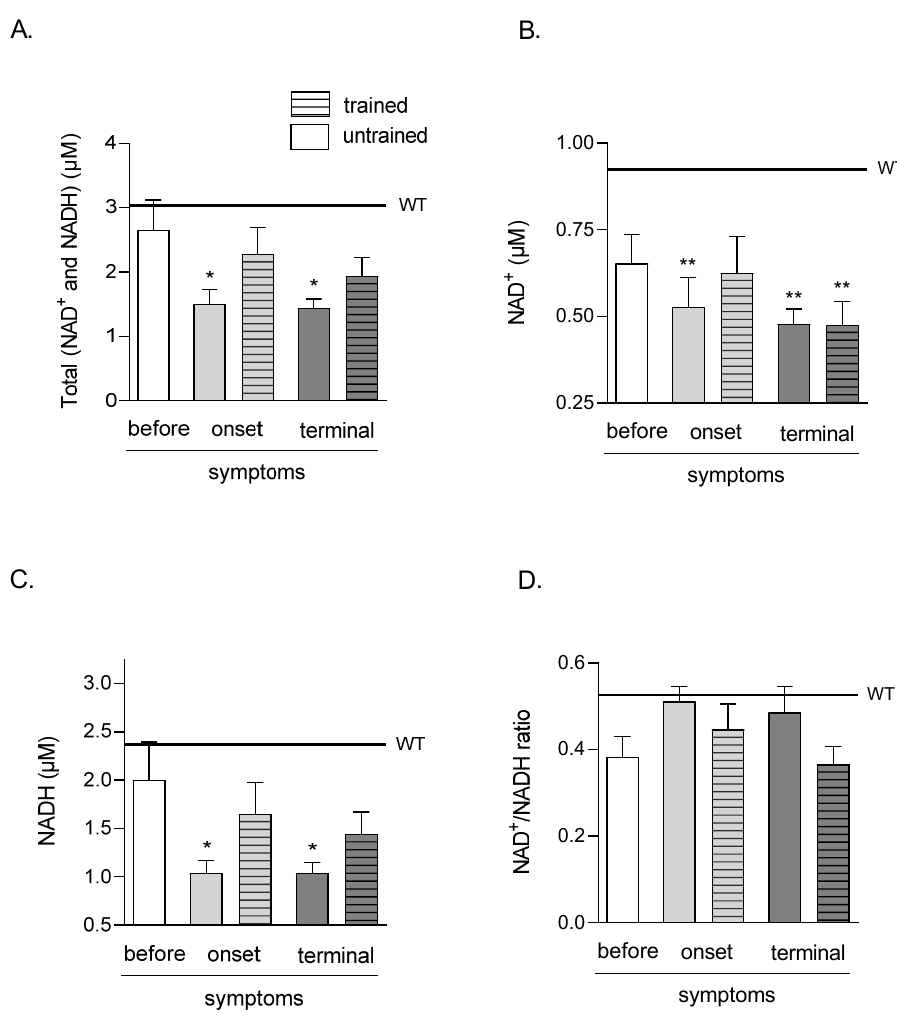
Figure 2. Effects of ALS disease progression and swim training on skeletal muscle amounts of total (NAD + and NADH), NAD + , NADH, and NAD + /NADH ratio. Total (NAD + and NADH) ( A ), NAD + ( B ), NADH ( C ) NAD + /NADH ratio ( D ) were measured in the tibialis anterior muscle of mice. There were significant differences between the groups: * p < 0.05 and ** p < 0.01 vs. WT group of mice (Tukey’s post hoc test). The data are presented as the means ± SEM ( n = 6 in each group). The amounts of NAD + in TA muscle were significantly lower in ONSET untrained and both TERMINAL (untrained and trained) groups (0.53 ± 0.08, 0.48 ± 0.04, and 0.48 ± 0.07 µ M in ONSET untrained, TERMINAL untrained and trained groups of mice, respectively) than in the WT group of mice (0.92 ± 0.04 µ M) (Figure 2B). NADH in the TA muscle was significantly lower in both ONSET and TERMINAL untrained groups of mice (1.04 ± 0.13 and 1.04 ± 0.11 µ M, respectively) than that in the WT group of mice (2.37 ± 0.36 µ M). Swim training did not significantly increase NADH in both groups of mice (1.65 ± 0.32 and 1.44 ± 0.23 µ M in ONSET and TERMINAL trained groups, respectively) (Figure 2C). There were no NAD + /NADH ratio changes in all analyzed groups (Figure